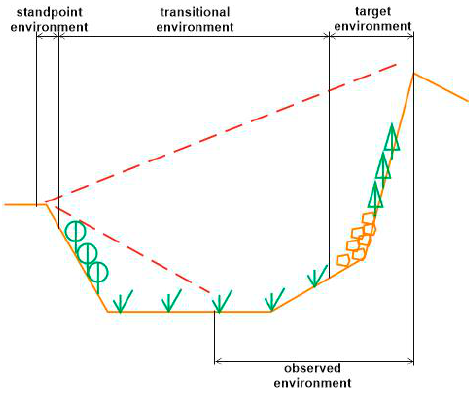
Figure 1. Main components of the viewpoint geosite environment.